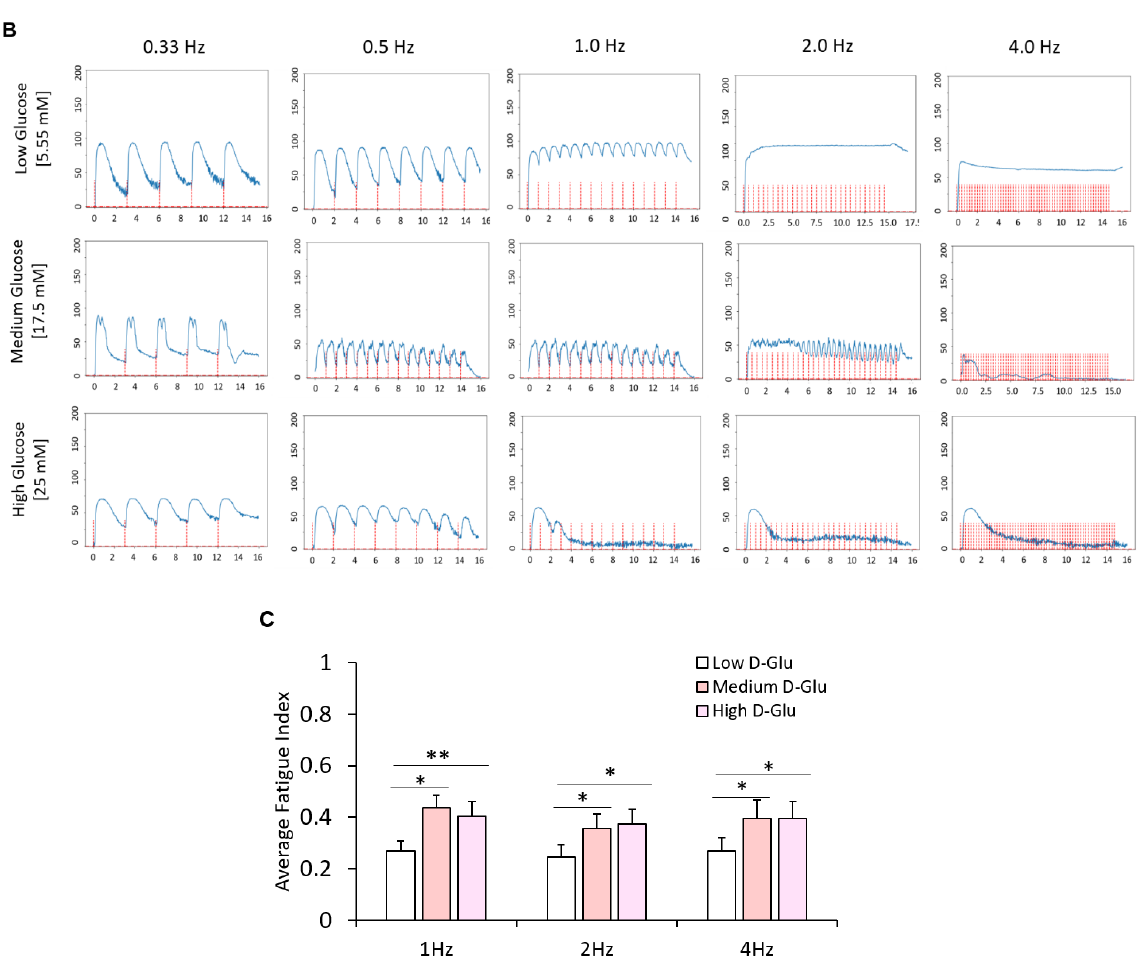
Figure 8. Functional characterization of myotubes differentiated from iPSC-derived myoblasts pre- viously cultured in the three D-glucose concentrations. ( A ) Phase images of iPSC-derived myotubes at day 7 of differentiation. ( B ) Contraction traces of iPSC-derived myotubes derived from 5.55, 17.5 and 25 mM D-glucose myoblast cultures at day 7 of differentiation. ( C ) Quantification of fatigue indices of myotubes at day 7 of differentiation. Error bars = SEM. P ≤ 0.1, *; P ≤ 0.05, **; P ≤ 0.01, ***. n = 5 for low glucose and 3 for medium and high glucose. Statistics were performed utilizing One- way ANOVA with post-hoc Tukey HSD Test.